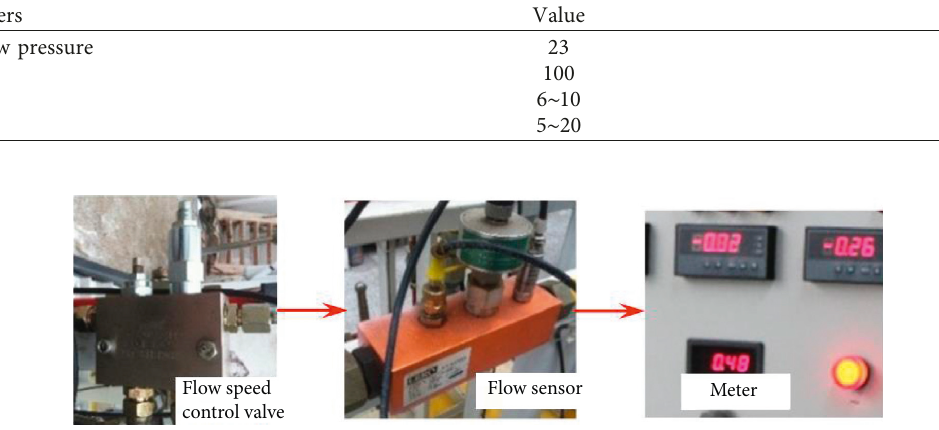
Figure 5: The adjustment and testing of the damping flow.